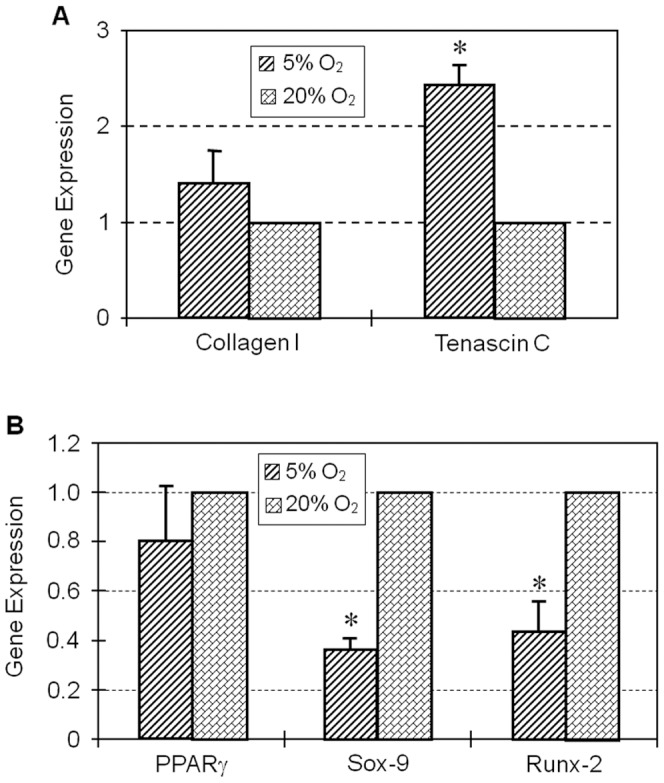
A. Tenocyte related gene expression by hTSCs under hypoxic and normaxic culture conditions.Total RNA extracted from hTSCs grown under hypoxic or normaxic conditions was used to synthesize cDNA, which was used as a template in qRT-PCR using primers specific to Collagen-1 and Tenascin C. GAPDH was used as an internal control. Y- axis represents relative gene expression when compared to GAPDH expression levels. Ct values were normalized against hTSCs cultured under 20% O2. At both oxygen conditions (5% and 20% O2), there was no significant difference in the expression of collagen type I, but the expression of tenascin C in the hypoxic group was significantly higher than in the normaxic group (*P<0.05). B. Non-tenocyte related gene expression by hTSCs under the above two oxygen conditions. Total RNA extracted from hTSCs grown under hypoxic or normaxic conditions was used to synthesize cDNA, which was used as a template in qRT-PCR using primers specific to PPARγ, Sox-9 and Runx-2. GAPDH was used as an internal control. Y- axis represents relative gene expression when compared to GAPDH expression. Ct values were normalized against hTSCs cultured under 20% O2. The cellular expression of PPARγ, a marker for adipogenesis, was not significantly different in 5 and 20% O2 conditions. However, Sox-9 and Runx-2 (markers for chondrogenesis and osteogenesis, respectively) were expressed at significantly lower levels when hTSCs were cultured at 5% O2 condition in comparison to 20% O2 (*P<0.05, respective to hTSCs that were under normaxic conditions).